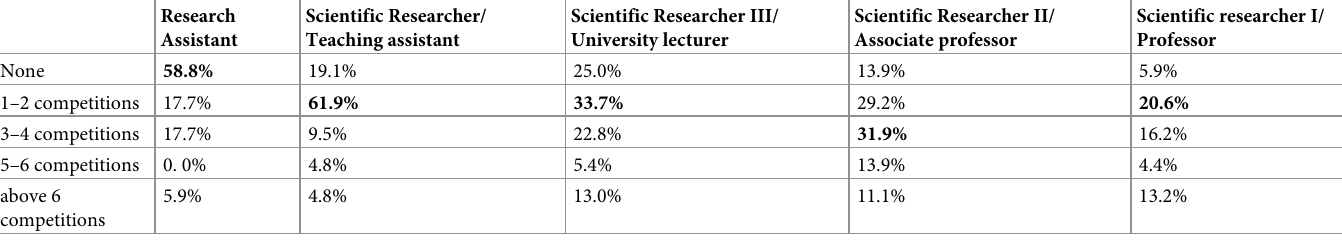
Table 3. Number of competitions in which respondents participated in the last 5 years by didactic or research rank of the respondents (the didactic and research ranks considered are specific to Romania, because there is no ranking system worldwide